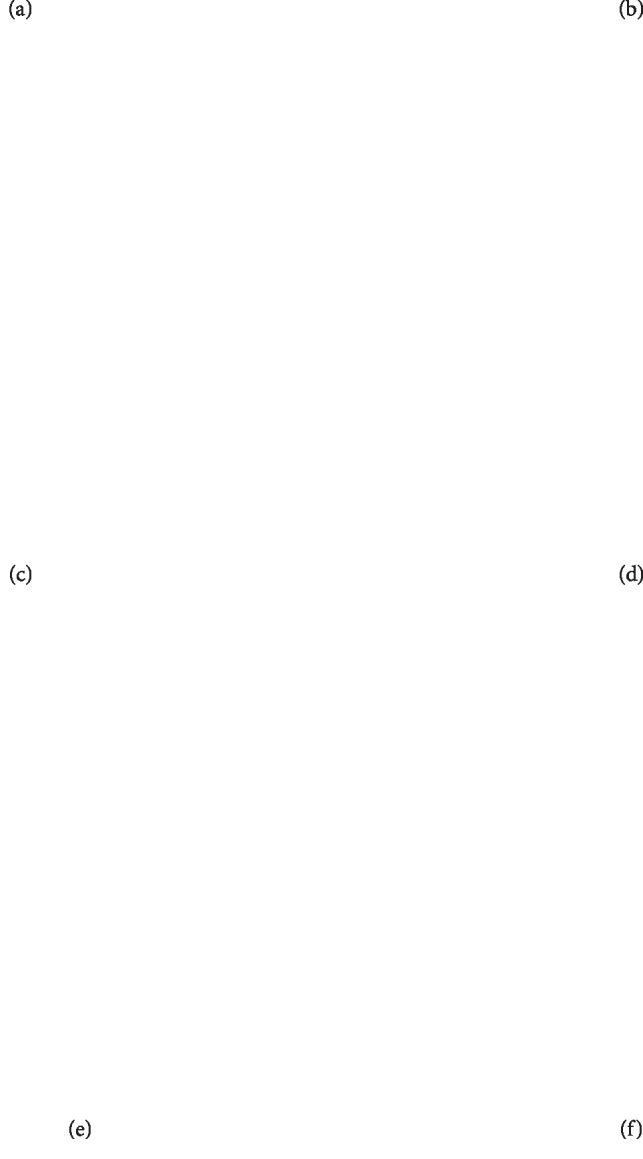
KXS inhibited the phosphorylation of Tau via the PI3K/Akt signaling pathway in vivo. Downregulation of p-PI3K, p-Akt, and p-Tau and upregulation of p-GSK-3β were shown in the rat hippocampus treated with KXS compared with those treated with a monotreatment of GR, PR, PO, and AT. The efficiency of KXS was detected (a) and quantitated (b) by western blot analysis. The expression of p-Tau (S396) in the rat hippocampus was performed with immunohistochemistry analysis (c and d). Each of the control groups were adjusted to the same level. The column diagrams marked by different letters were significant to each other at the 0.05 level according to Duncan's multiple range test. Values were mean ± SE (n = 6), scale bar = 50 μm.